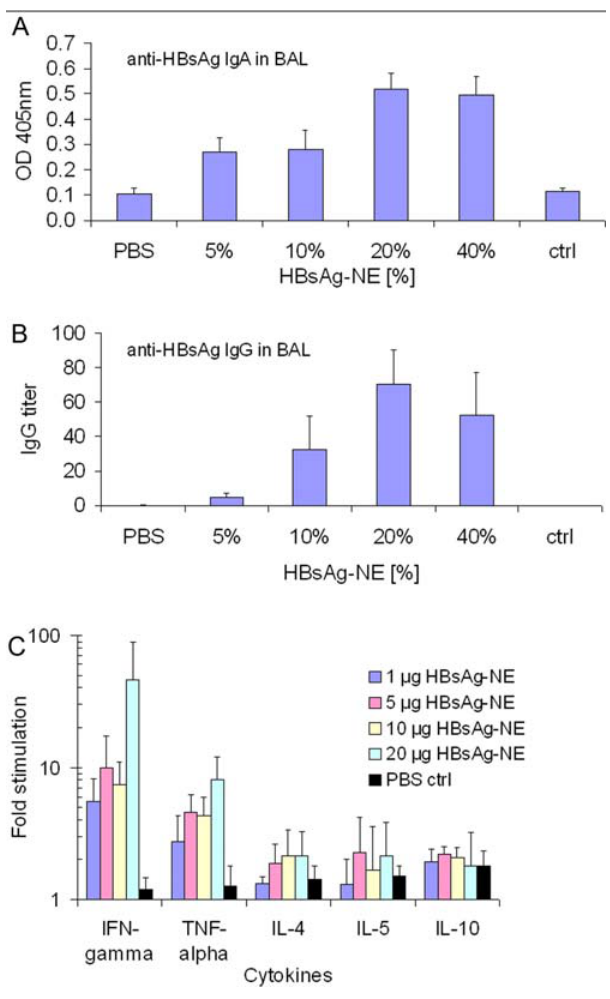
Figure 5. Characterization of immune response mucosal and cellular responses to HBsAg-NE. Mucosal antibody measurements were performed in BAL fluids obtained 23 weeks after i.n immunization with HBsAg-NE vaccines. IgA detection: The anti-HBsAg IgA detection was performed with 1:2 dilutions of BAL (A). Results are presented as mean values of OD at 405 nm + / 2 SEM. IgG detection: The anti-HBsAg IgG antibody concentrations are presented as end point titers (B). Antigen-specific cytokine expression. Pattern of Th1 (IFN- c and TNF- a ) and Th2 (IL-4, IL-5 and IL-10) cytokine expression in vitro in splenocytes from mice intranasally immunized with HBsAg-NE (C). Splenocytes were obtained at 23 weeks after initial immunization from mice with HBsAg-20% NE. Results are presented as fold increase of the cytokine production over levels detected in non-stimulated splenocyte cultures.